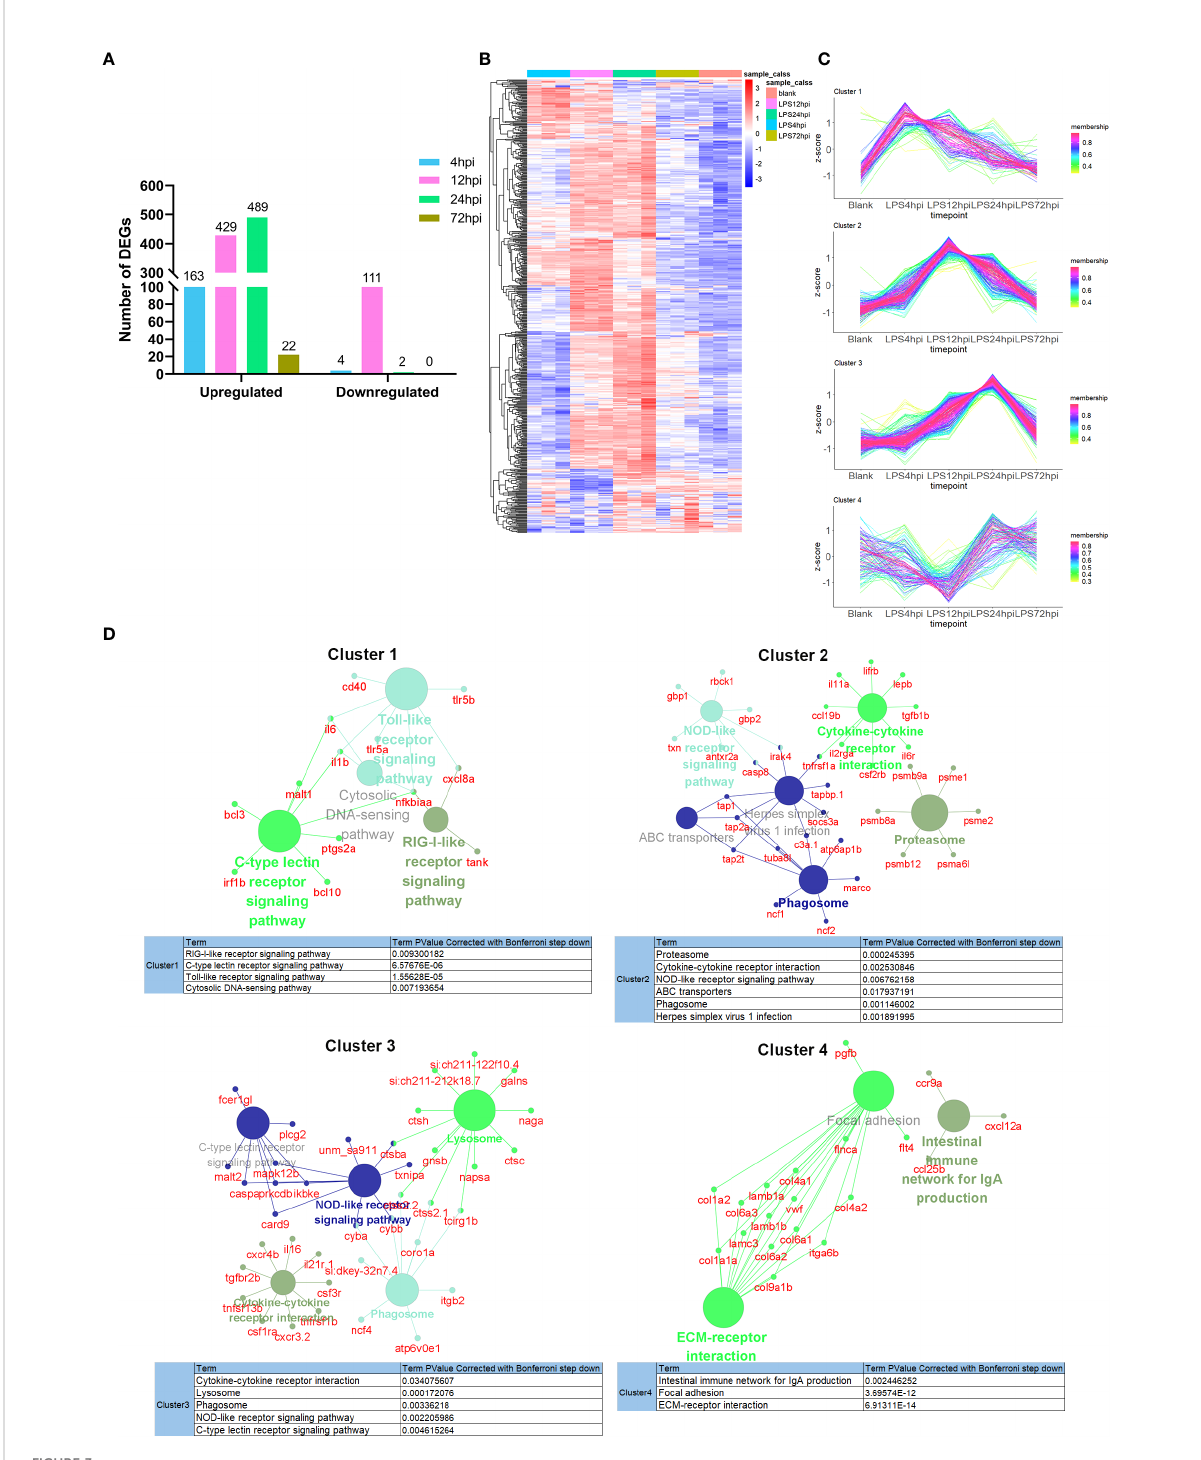
FIGURE 3 Transcriptomic traits of EIU in zebra fi sh. (A) Number of DEGs at 4 hpi, 12 hpi, 24 hpi and 72 hpi of LPS and saline. (B) Hierarchical clustering heatmap of DEGs at each time point. (C) The TCseq package was used to illustrate the patterns of dynamic changes in DEGs during EIU in zebra fi sh. (D) Functional enrichment analysis of DEGs in different clusters. Networks of pathways and genes in Cluster 1, Cluster 2, Cluster 3 and Cluster 4 were conducted by ClueGO and displayed by Cytoscape. Circles shown in the same color represent similar enrichment